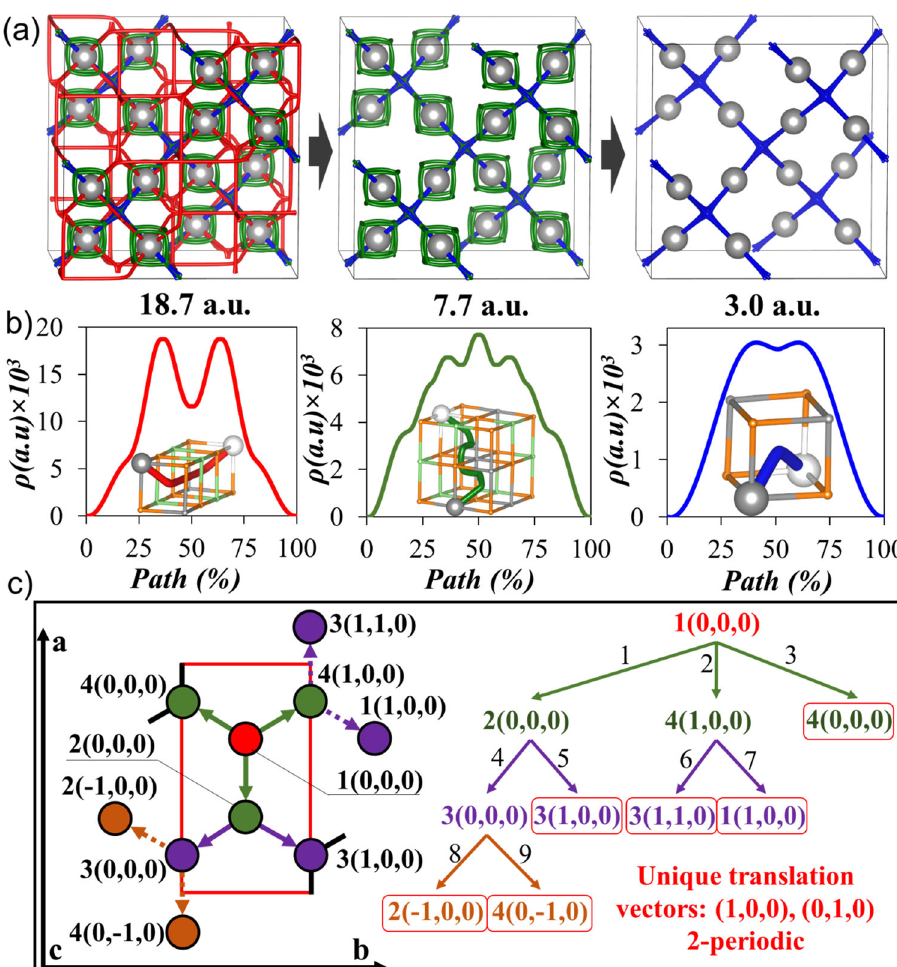
Fig. 7 Analysis of ion migration map. a Searching for the lowest barrier periodic Li migration map of LiTiS 2 . b MEDPs between neighboring Li sites. c The algorithm for calculating the periodicity considering as an example a hexagonal net. The algorithm needs 9 steps to travers all